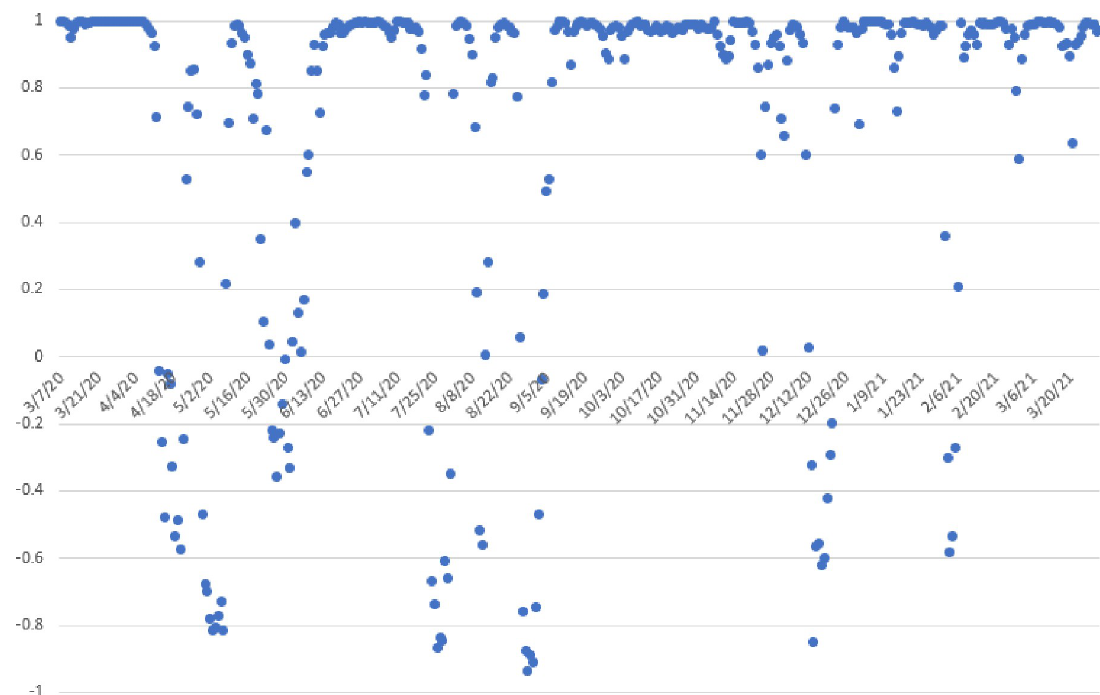
Fig 2. Seven-day rolling correlation between 7-day rolling average of estimated new daily COVID-19 cases among agricultural producers and among the general population.